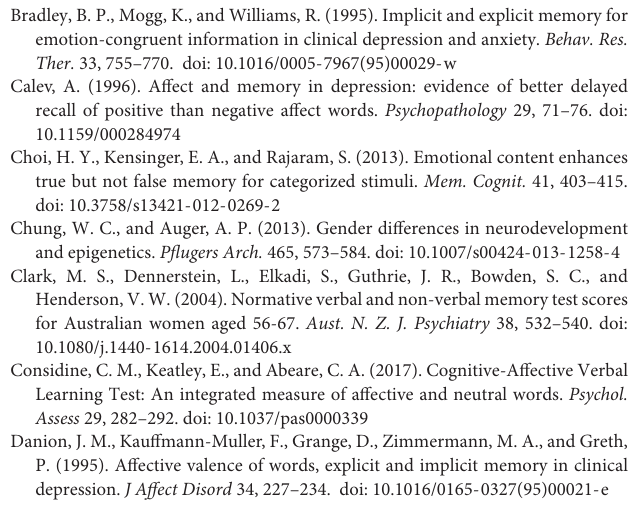
FIGURE S1 | Q–Q plots of the residuals of the twelve univariate regression models used to model the mean and its variance of the nine VAMT-24 recall outcomes and their sum. The shaded area in dark gray 95% represents pointwise confidence intervals for the points of the QQ-curve (Oldford, 2016). FIGURE S2 | Distribution of VAMT-24 and VAMT-26 percentage recall rates. Histograms of the distribution of VAMT-24 and VAMT-26 recall-% scores adjusted for age, sex, IQ and educational level. The y -axis (density) indicates to the relative frequency normalized such that the area covered by the bars of the histogram equals 1. FIGURE S3 | Bland-Altman plots of test–retest VAMT-26 total scores. The graphs show on the x -axis the average value of the two test sessions and on the y -axis the difference between the two test sessions for IMR Total (left panel), STM Total (middle panel) and LTM Total (right panel). The red line indicates the expected difference between the two sessions, the blue and green dashed lines represent the lower and upper bound of the limits of agreement (i.e., 95% prediction interval for the difference between the test and retest values). The shaded areas represent the confidence intervals for the bias and bounds of the limits of agreement. TABLE S1 | Descriptive data for IMR 1–5 recall trials, primacy and recency effects. TABLE S2 | Established covariates of